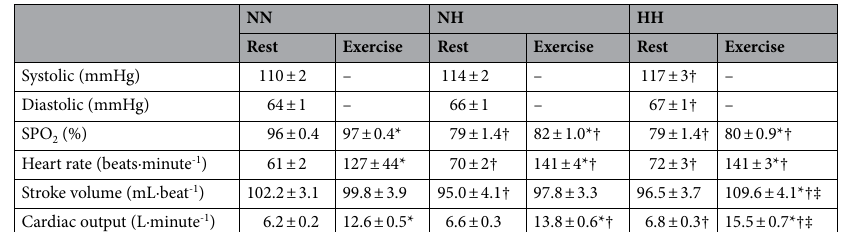
Table 1. Cardiovascular variables at rest and exercise following acute exposure to normobaric normoxia (NN), normobaric hypoxia (NH), and hypobaric hypoxia (HH). * p < 0.05 from Rest. † p < 0.05 from NN. ‡ p < 0.05 from NH. Data presented as means ±